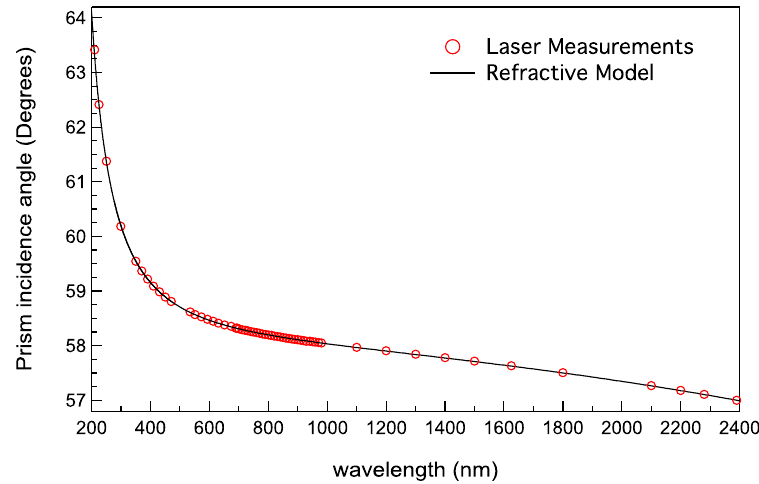
Figure 7. Spectral wavelength definition for prism angle refractive geometry at the ESR detector focal plane position. The full instrument refractive model is optimized based on direct laser measurements to the centroid of the individually measured spectral response functions (shown below in Figure 8). The global standard deviation of the wavelength fit here is <0.1%.